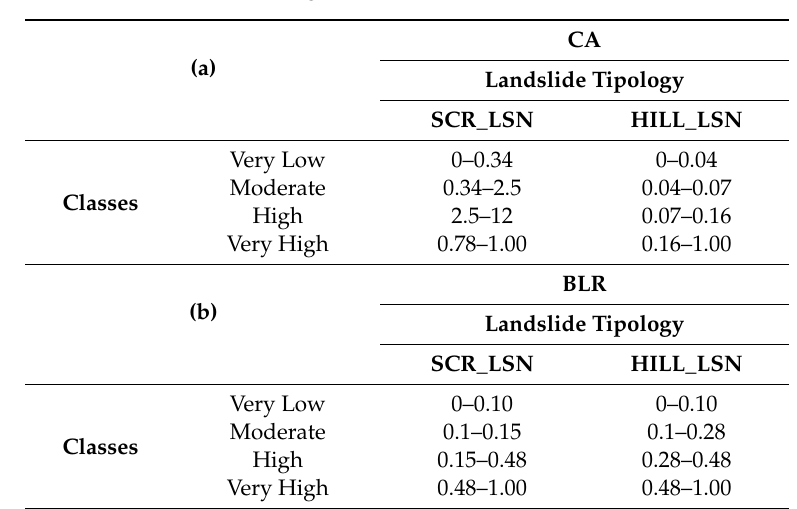
Table 7. Cuto ff range for (a) HILL_LSN and (b)